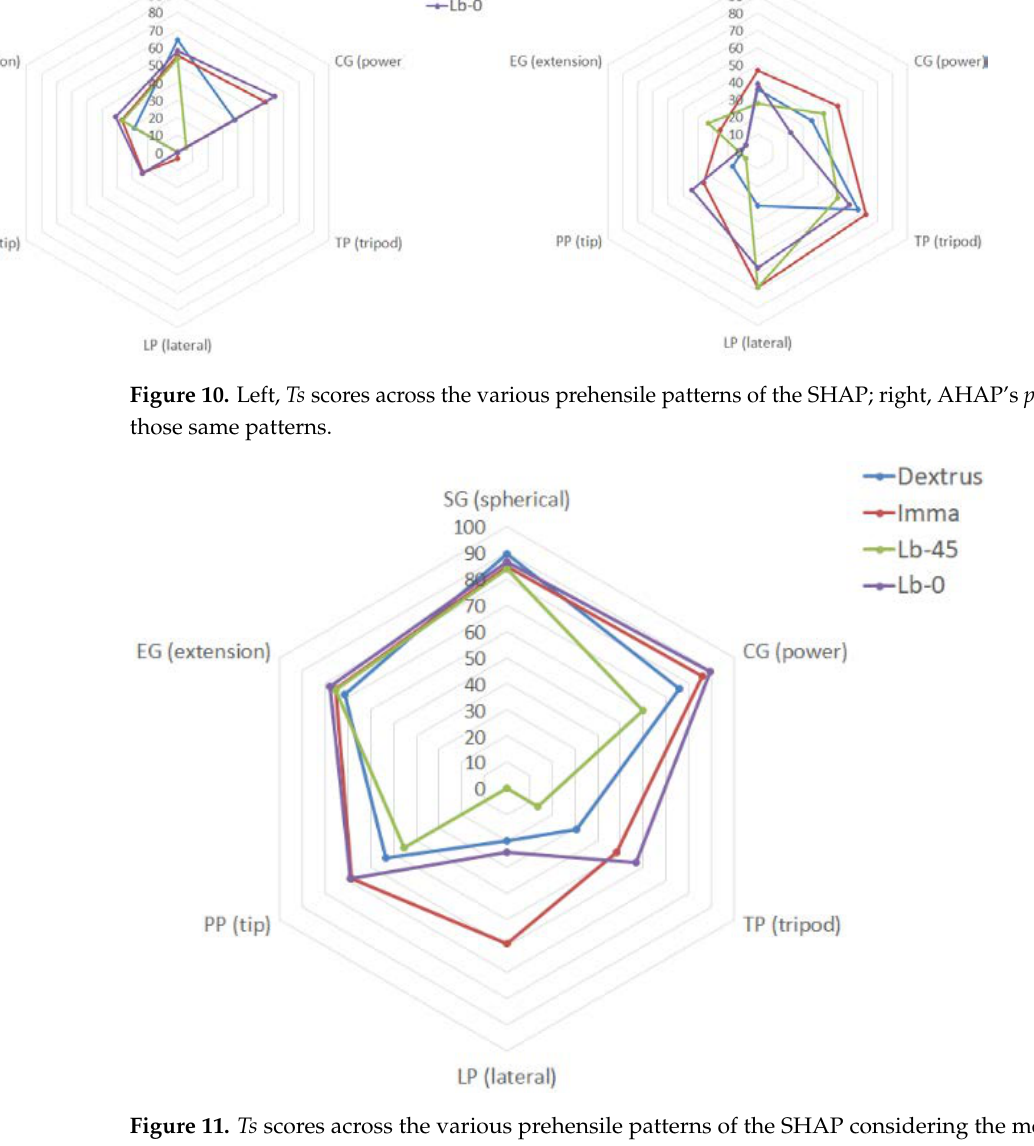
Figure 11. Ts scores across the various prehensile patterns of the SHAP considering the mean and limit times doubled concerning those of [54].